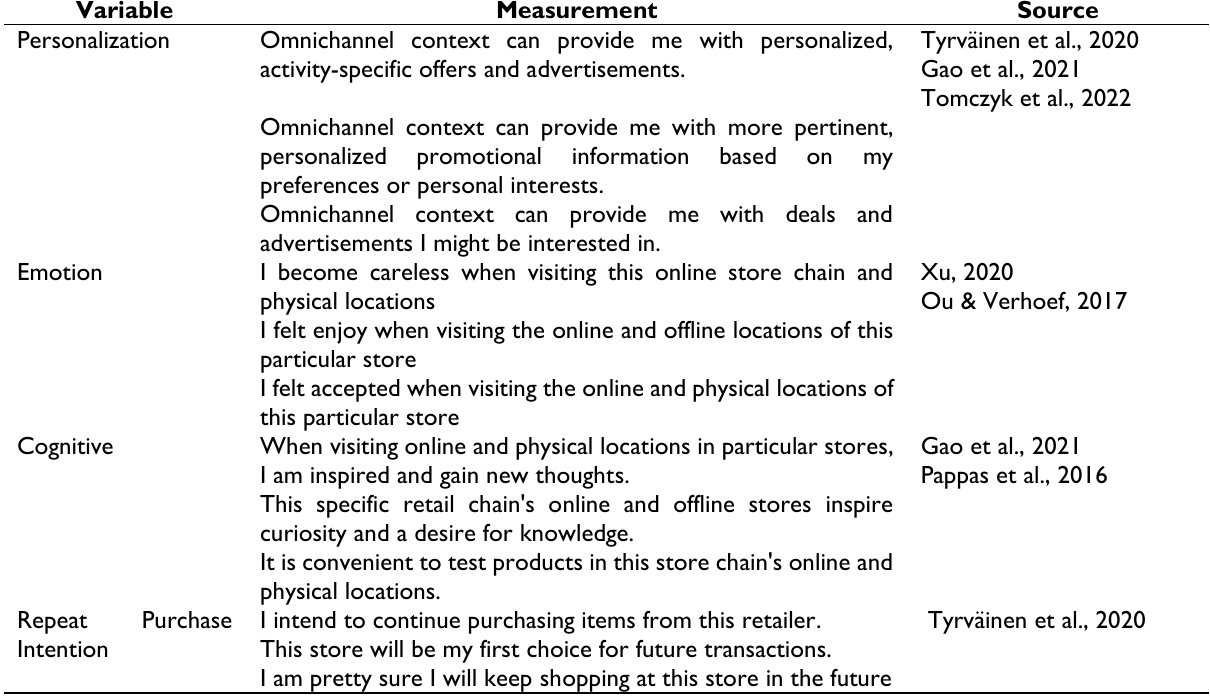
Table 1. Definition of Operational